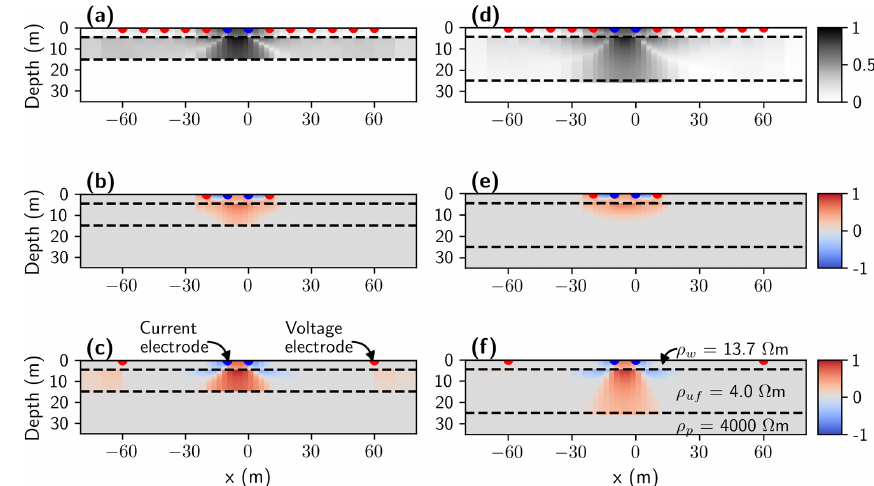
Figure 5. Two-dimensional normalized sensitivities for two different model scenarios developed for the Bykovsky field site. Position of the IBPT at a depth of (a–c) 15m and (d–f) 25m. From top to bottom, we show the cumulative sensitivity and the sensitivity for the shortest and widest quadripole, respectively.